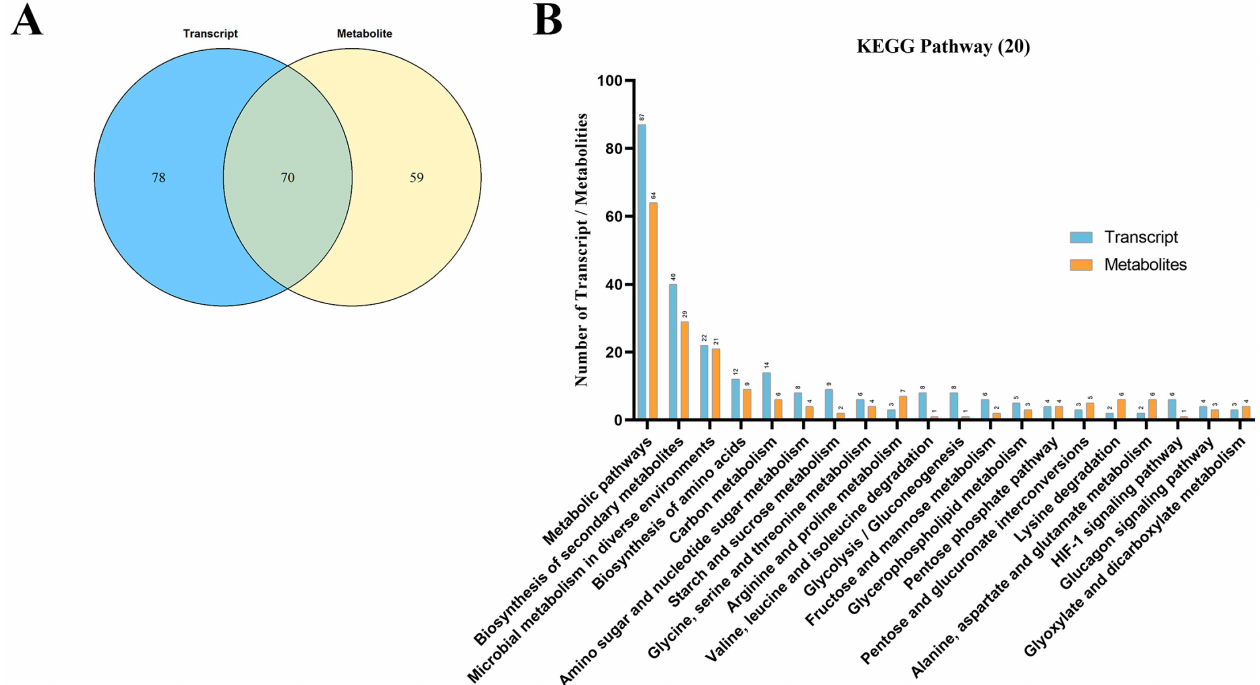
Figure 7. Transcriptomics–metabolomics integrative analysis in P. italicum treated with 2 − CDs. ( A ) Venn diagram of the differentiated genes and metabolites. ( B ) Top 20 pathways with the largest number of DEGs and DAMs.